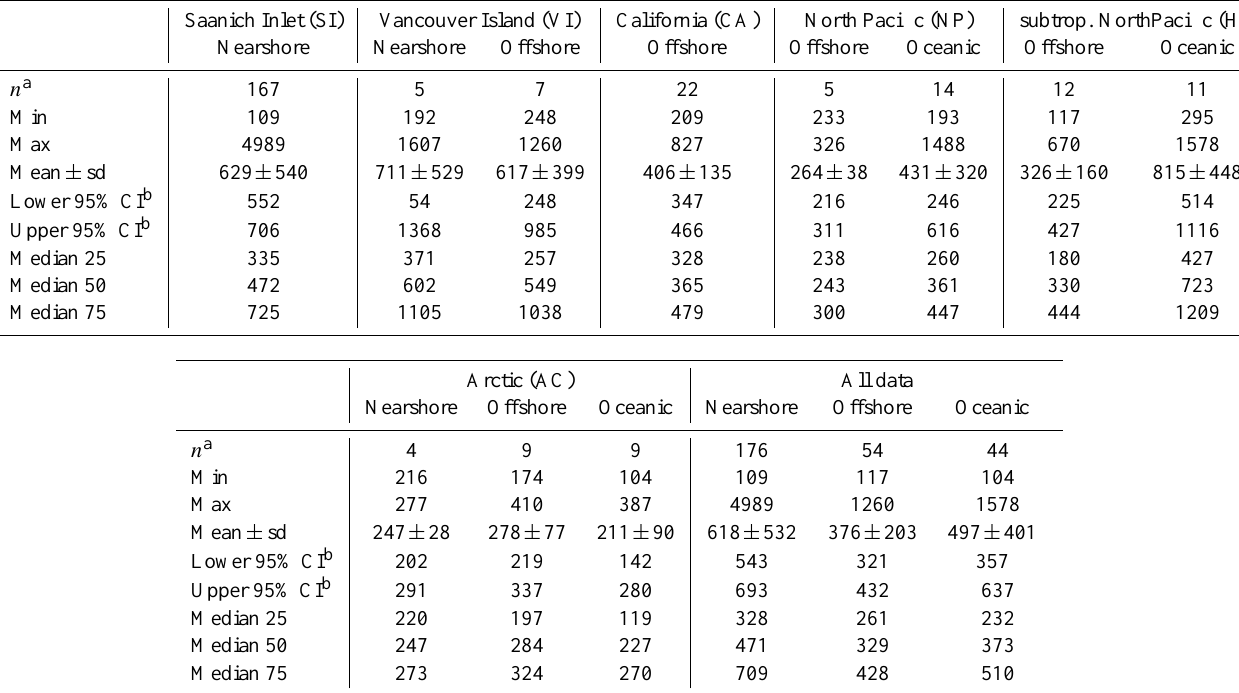
Table 5. Statistical data on the concentration (in µgTeqL − 1 ) of surfactants in the microlayer at different study areas.